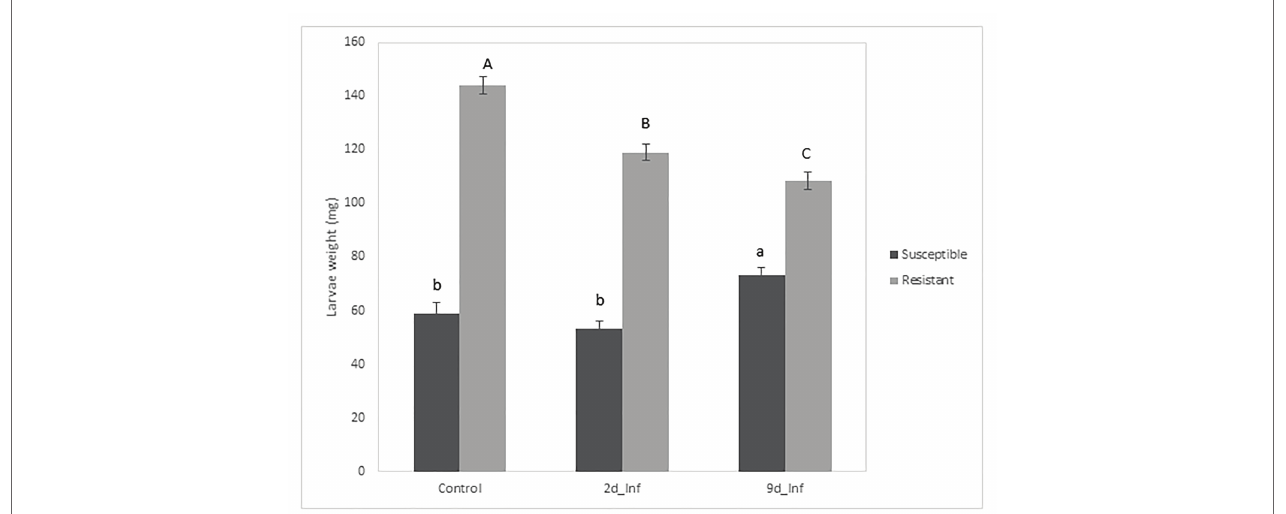
FIGURE 2 | Means of treatments applied to two inbreds for MCB larval weight at the end of the bioassay. Mean comparison among treatments was separately made for each inbred (uppercase letters for the resistant inbred and lowercase letters for the susceptible inbred).